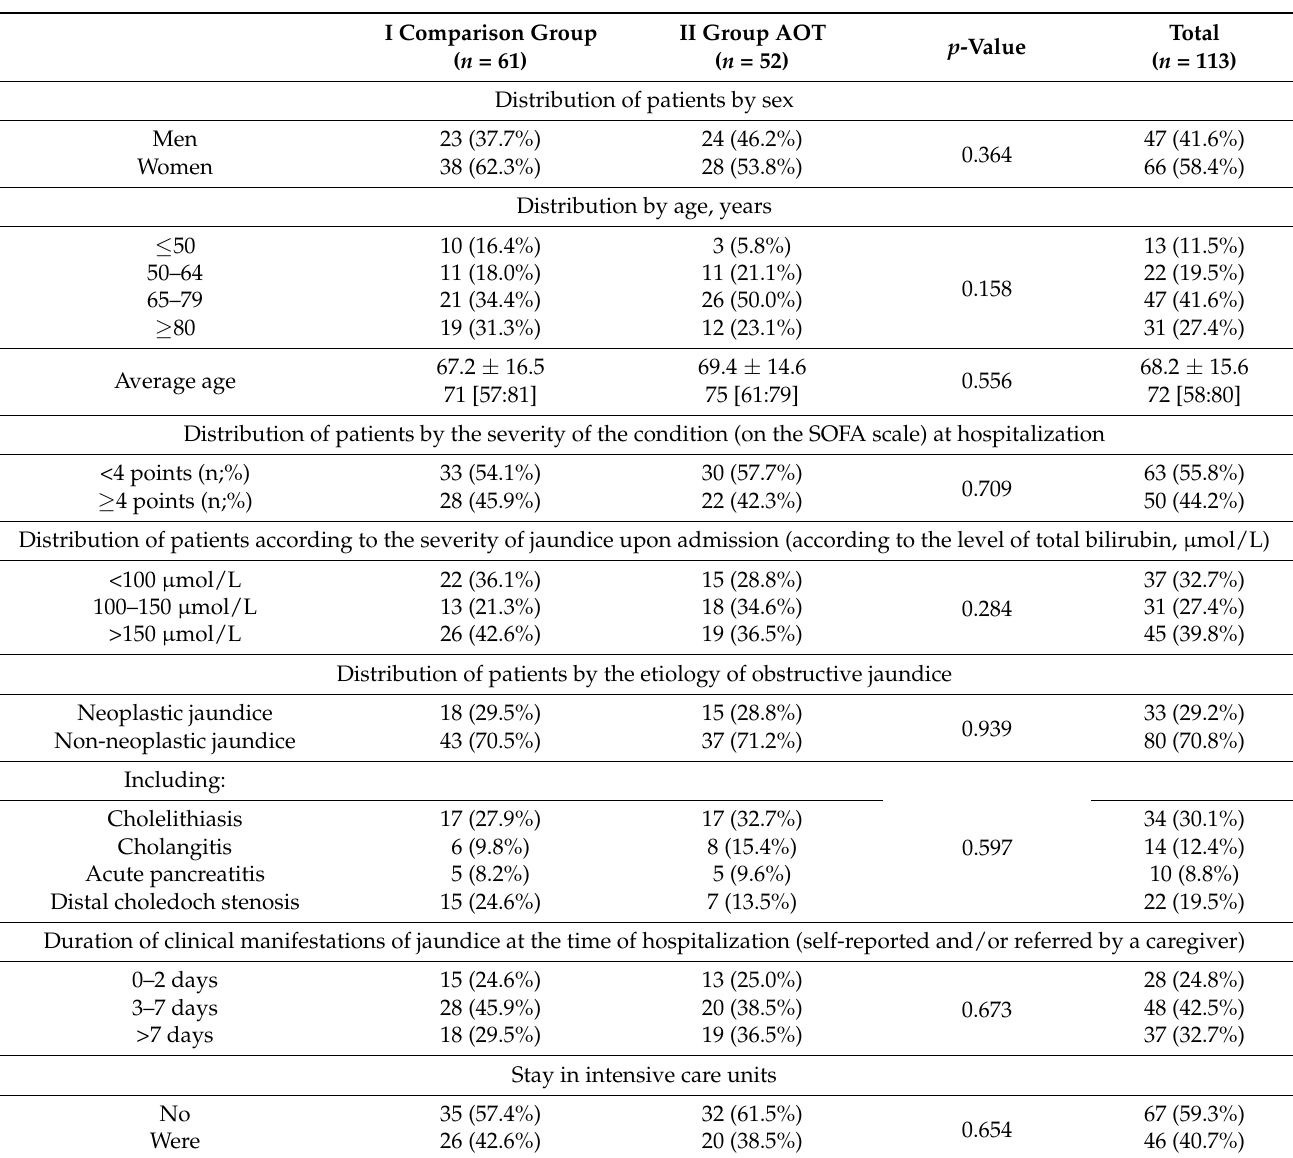
Table 1. Distribution of patients by sex, age, duration, severity, severity, and etiology of OJ at